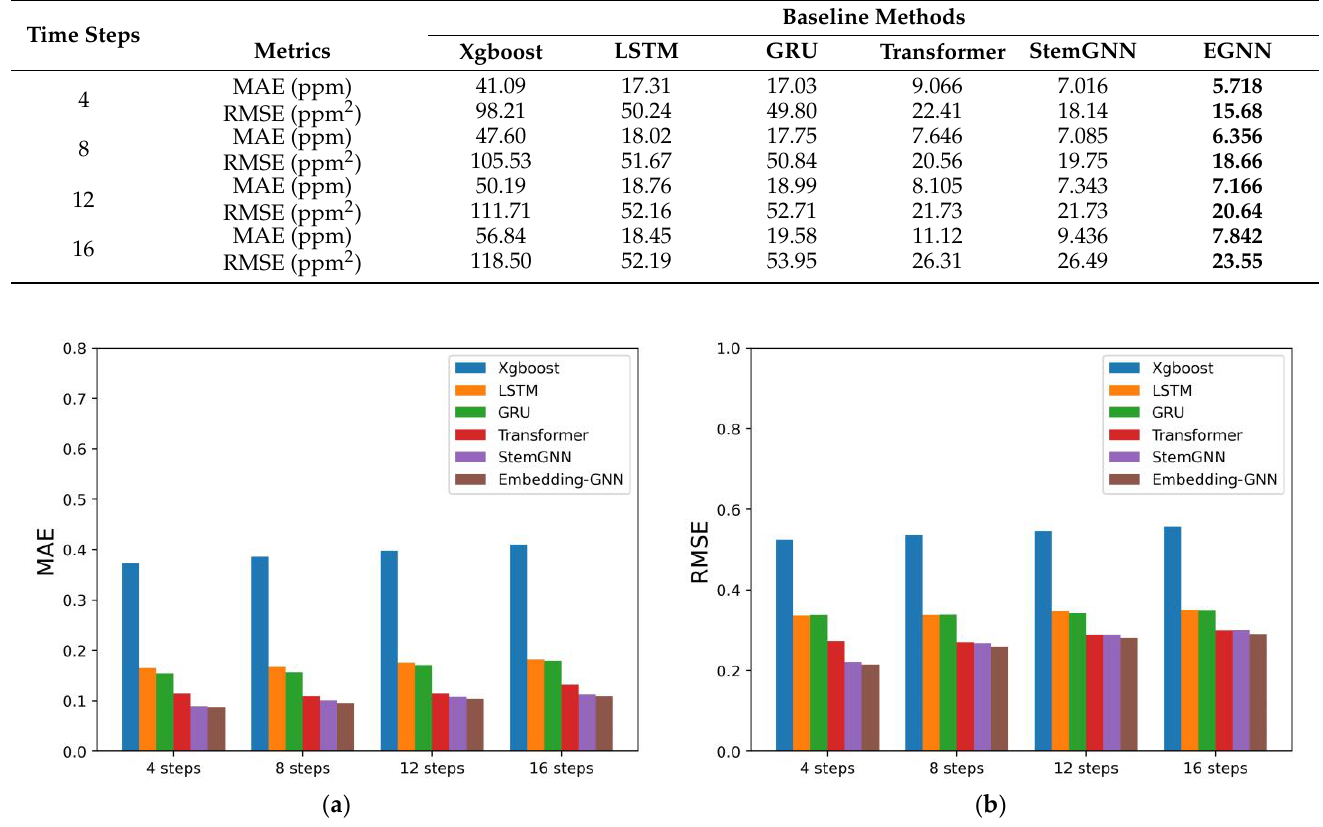
Figure 14. Normalized prediction results of different methods. ( a ) MAE. ( b ) RMSE.